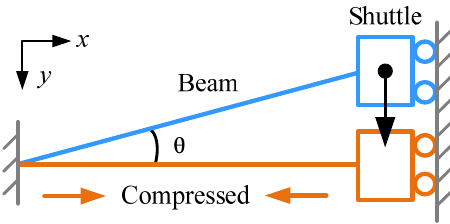
Figure 1. Schematic diagram of stiffness